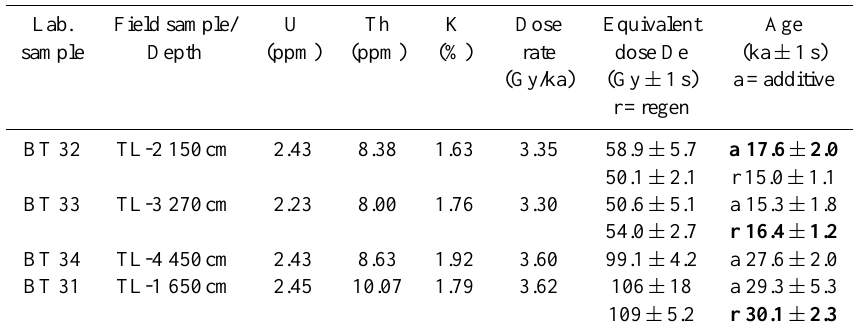
(Gy/ka) (Gy ± 1s) a=additive r=regen